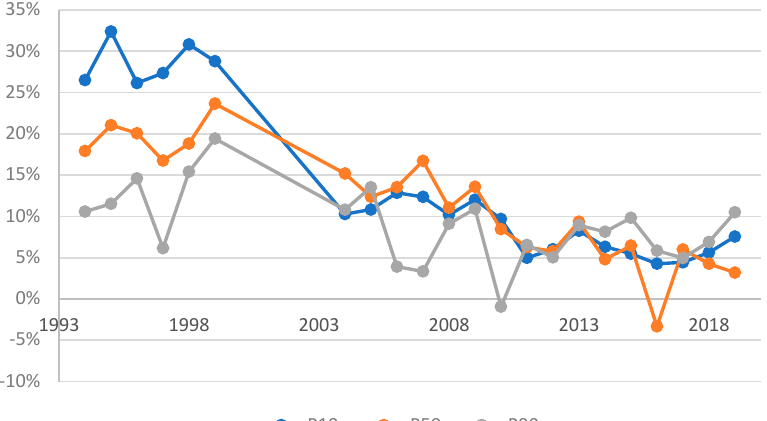
Figure A1. The gender wage gap at selected percentiles Source: Authors’ calculations using the ESRI Survey of Income Distribution, Poverty and Usage of State Services and the European Union—Survey of Income and Living Conditions. Notes: Limited to respondents aged 25–55 and excluding the self-employed. Wages are CPI adjusted and weighted.